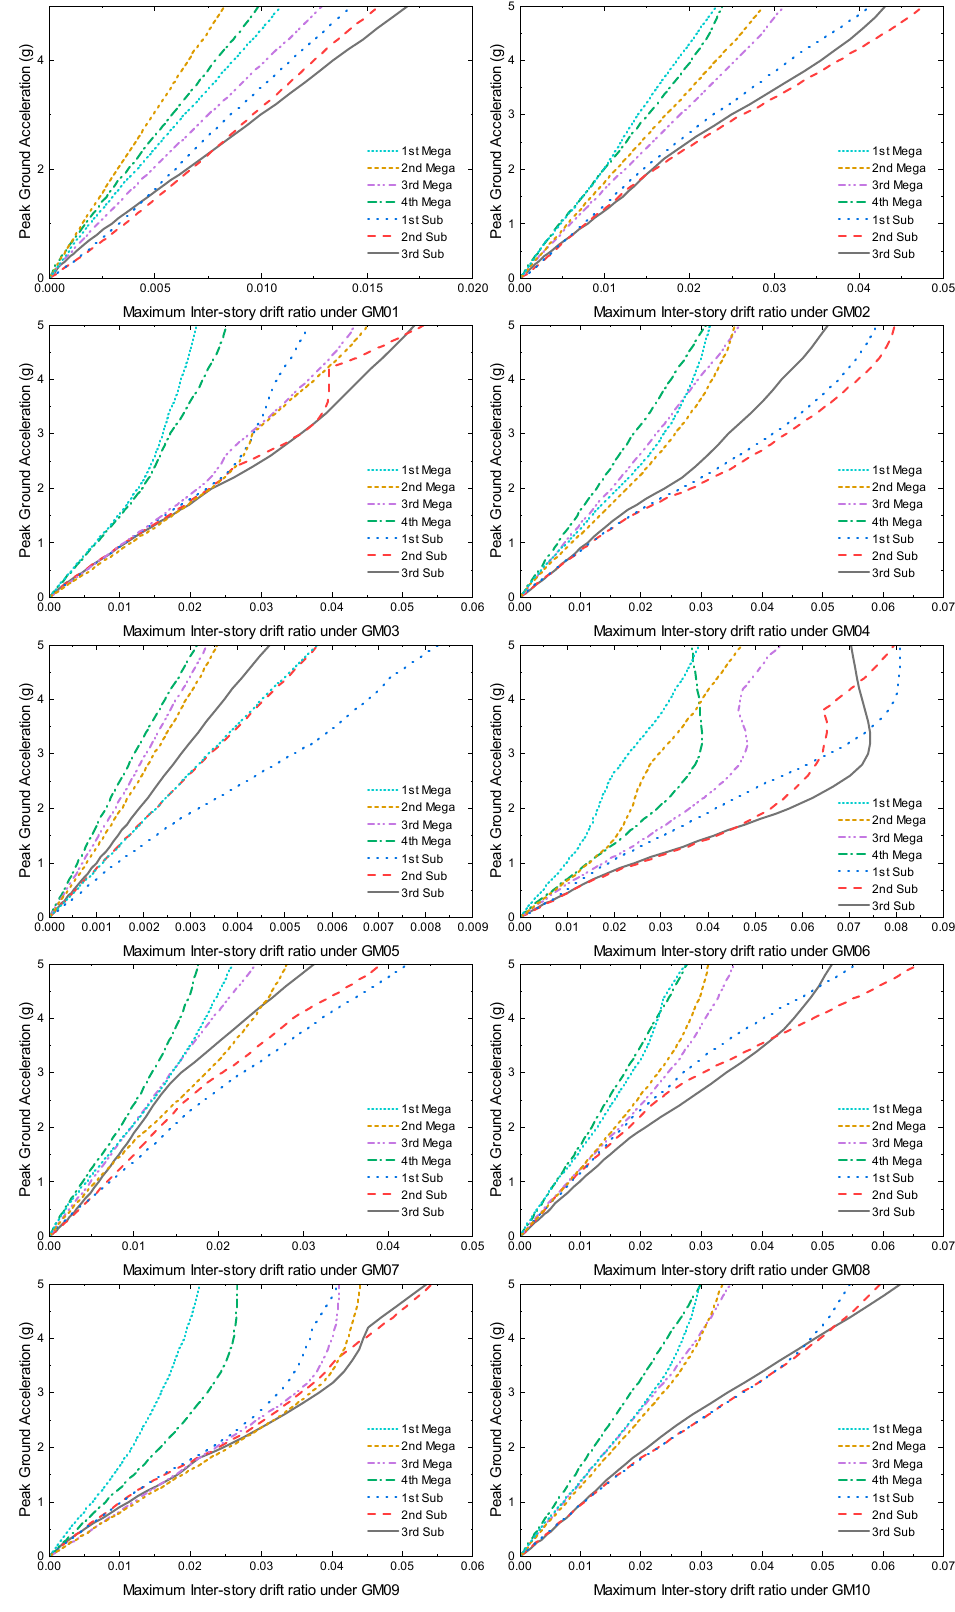
Figure 7. IDA curves for each mega-floor and sub-structure under different ground motions.